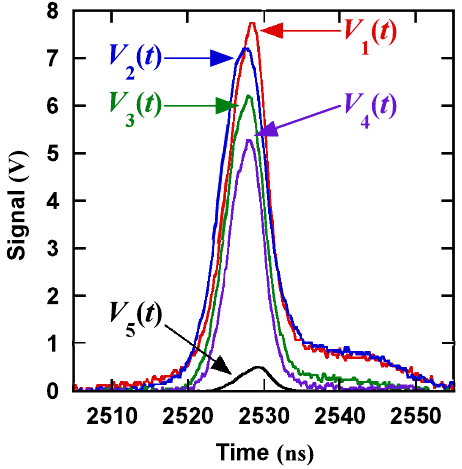
ð t Þ for Z -shot 165 FIG. 3. XRD voltage signals V i ; . . . ; R , Fig. 2). In this experiment the signal-to-data- ( R 1 b 5 b ð t Þ =V ð t Þ , was independent of channel conversion factor, (cid:4) ¼ D i i (cf. Appendix A). The signals do not necessarily peak